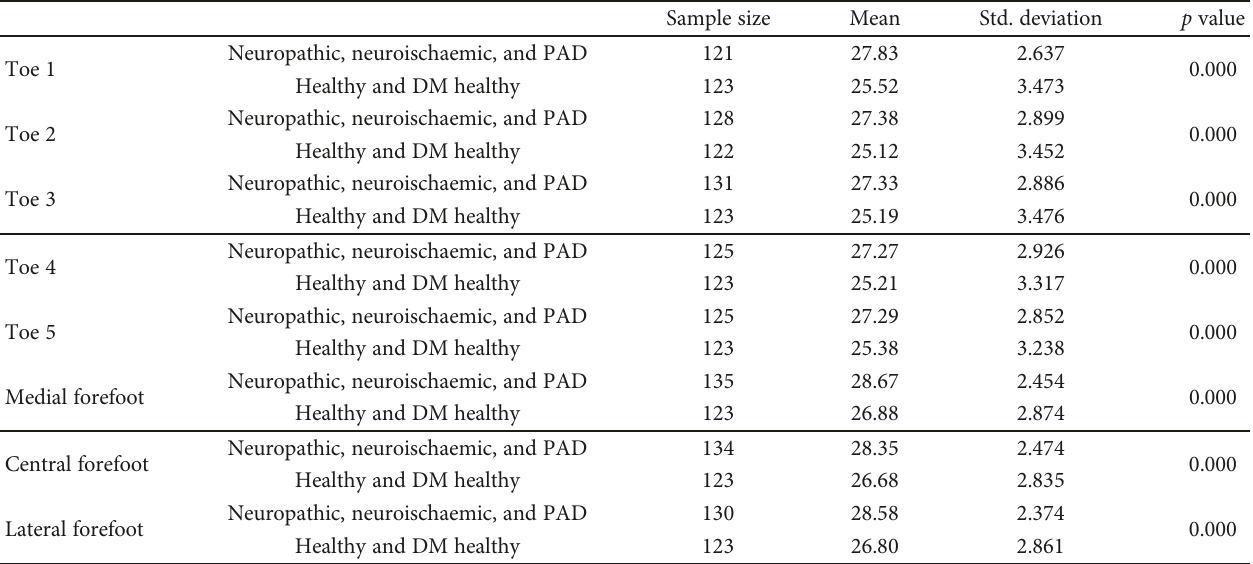
Table 1: Tukey test to compare mean temperatures between the two groups.